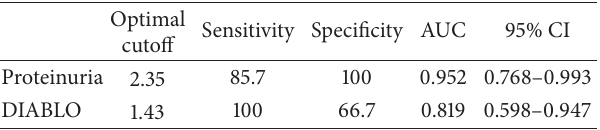
Table 3: Cutoff values form ROC curve analysis that discriminate failed and survived grafts with the best combination of sensitivity and